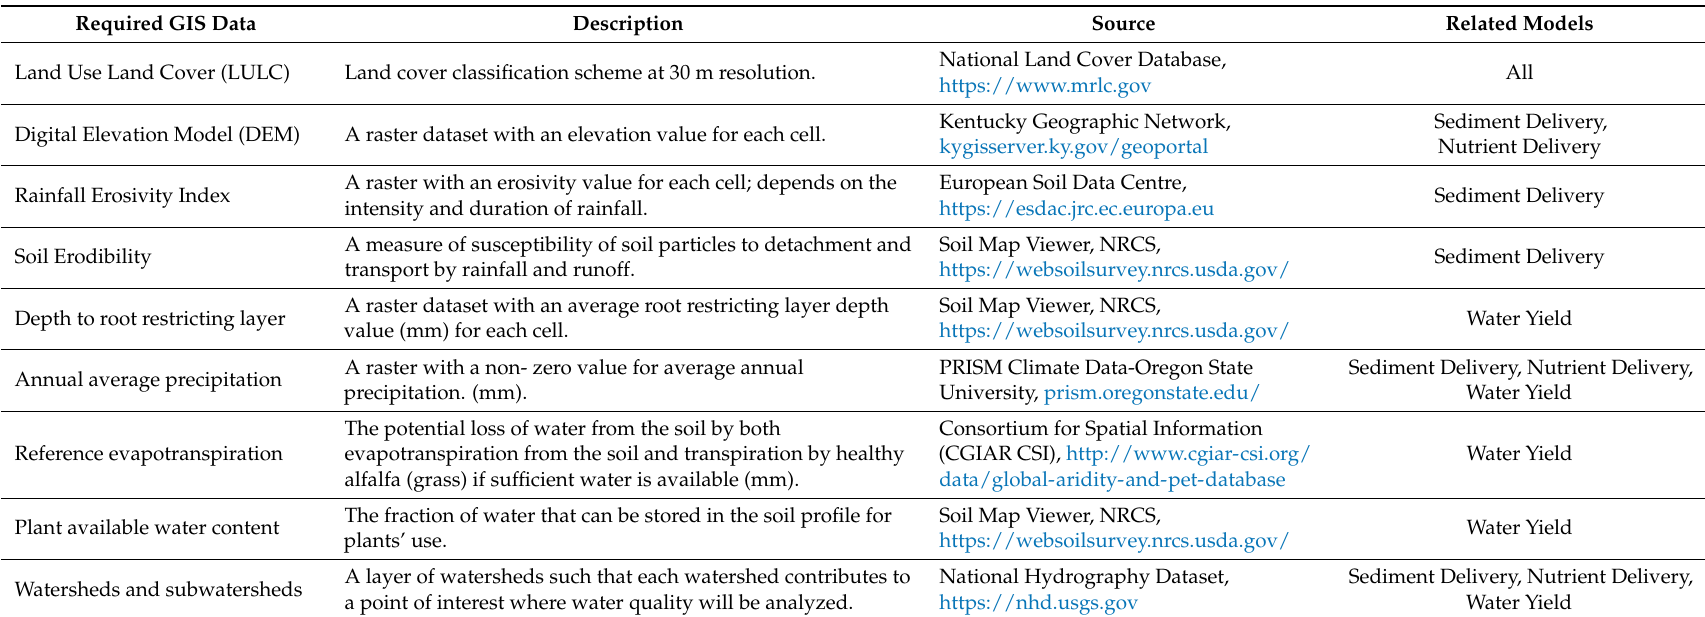
Table A3. GIS data layers needed for the InVEST